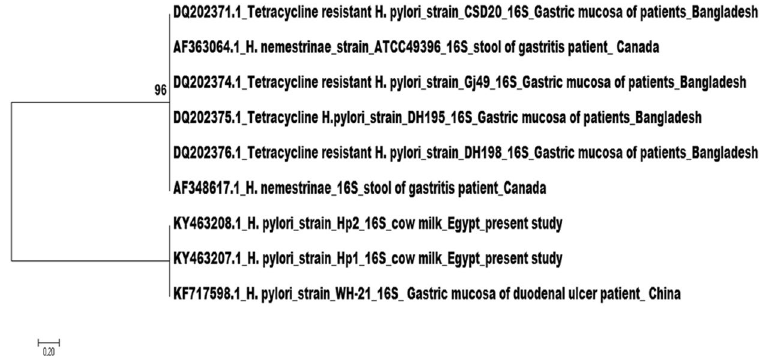
Figure 3. Evolutionary relationship between the strains isolated in the present study and those retrieved from the gene bank based on Helicobacter genus-specific 16s. The phylogenetic tree was constructed by using the neighbor-joining method and the evolutionary analysis was conducted in MEGA7. The analysis involved nine nucleotide sequences, two represents the strains of the present study and eight that had 90–100% identity with our sequences. The evolutionary distances were calculated and expressed in the units of the number of base differences per sequence. The numbers on the nodes (shown on the left next to the branches) indicate the number of times (percentage) the species grouped